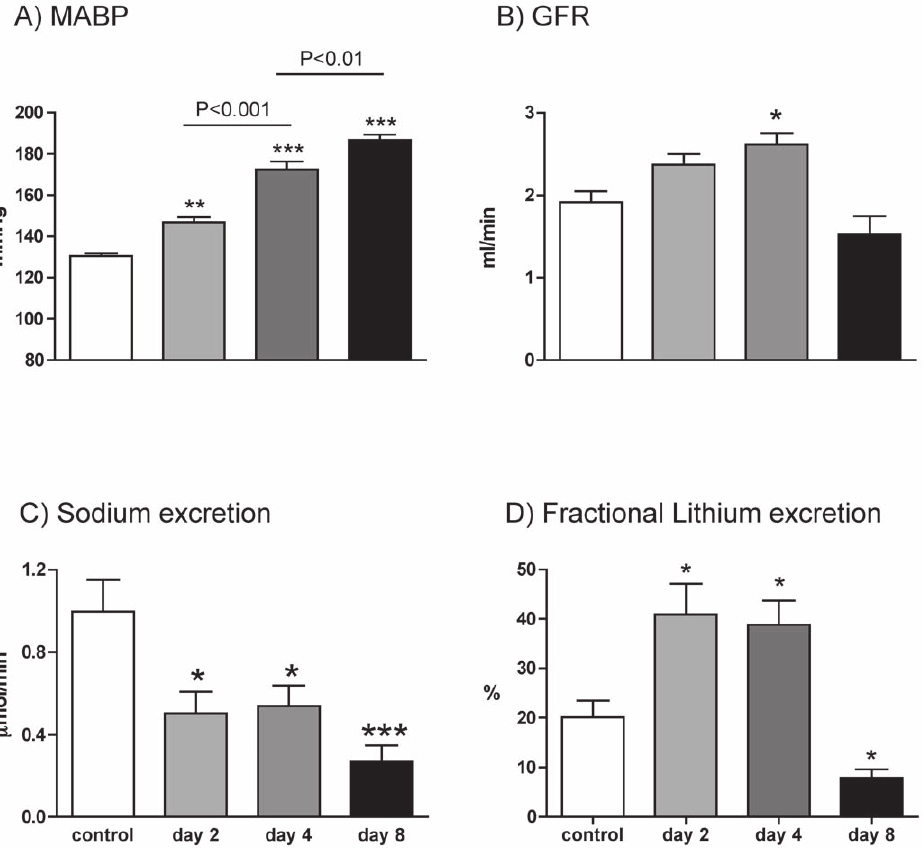
Figure 2. Renal function in anaethetized rats. A) mean arterial blood pressure (MABP); B) glomerular filtration rate (GFR); C) urinary sodium excretion and D) the fractional excretion of lithium. Measurements were made in cyp1a1-Ren2 transgenic rats, on either day 2 (n=9), 4 (n=9) or 8 (n=9) in the induction regimen. Non-induced rats (n=8) served as control. Data are mean 6 SE. Statistical comparisons were made using ANOVA with Bonferroni post-test. ***P , 0.001, **P , 0.01, *P , 0.05 versus the control group.